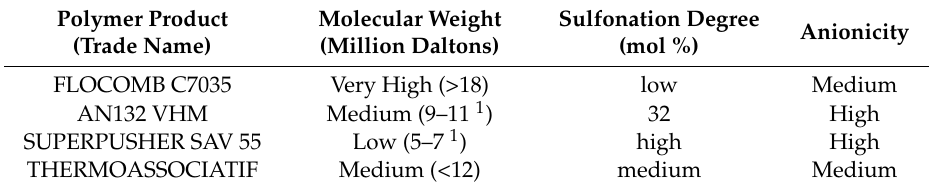
Table 1. Polymer Table 1. Polymer characteristics.